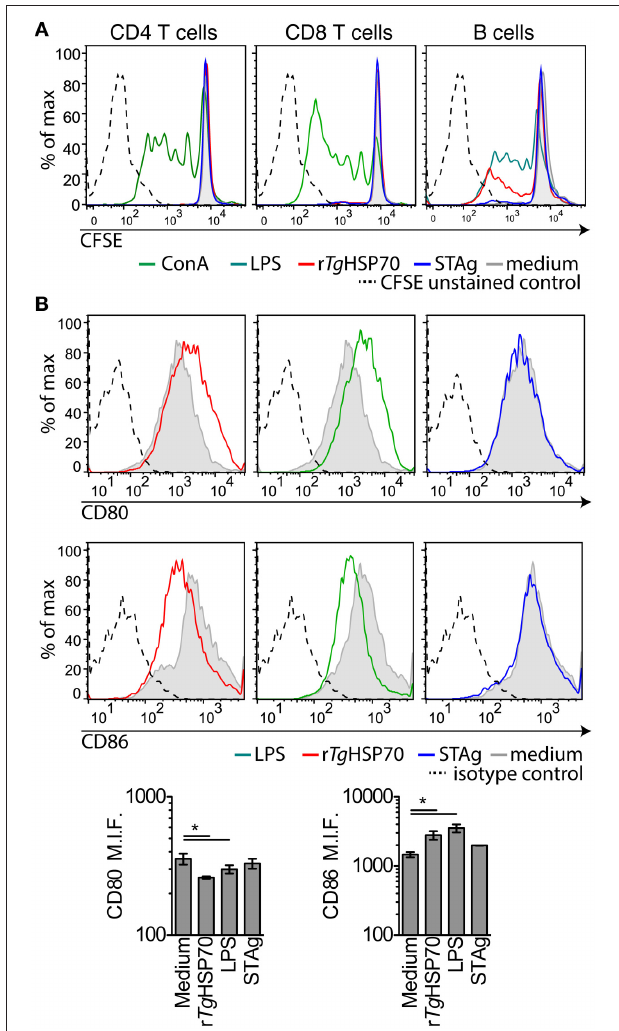
FIGURE 3 | r Tg HSP70 induce B cell proliferation and enhance CD86 surface expression. Spleen cells from PBS-immunized group were harvested, marked with CFSE and stimulated with r Tg HSP70 (10 µ g/mL), ConA (2.5 µ g/mL), LPS (1 µ g/mL), STAg (10 µ g/mL), or medium for 72 h. (A) Proliferation of B (CD19 + ), CD4 + , and CD8 + lymphocyte populations after incubation with each stimuli, individually. (B) B cells were evaluated for expression of CD80 and CD86 surface molecules by flow cytometry. Barplots represent the levels of median fluorescence intensity for CD80 and CD86. Data are representative of two independent experiments with five mice per group. * P < 0.05, one-way ANOVA. Error bars indicate mean ± SEM.